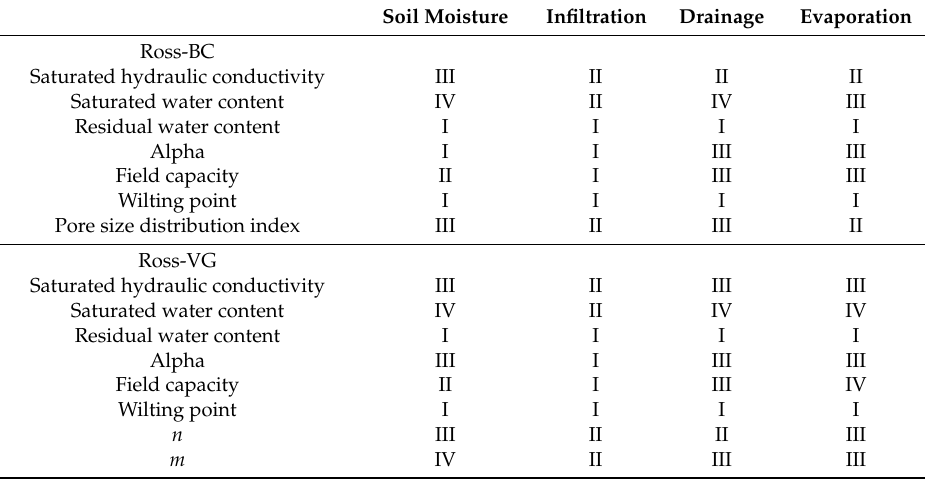
Table 5. Sensitivity of Ross model output to soil hydraulic input